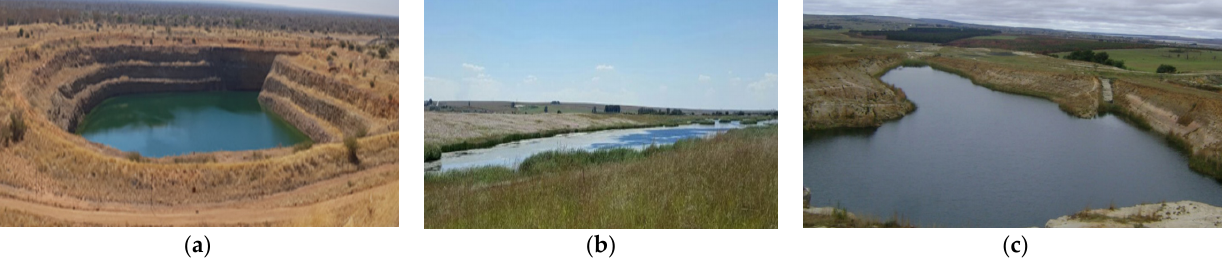
Figure 2. ( a ) Mafutha pit lake (September 2018); ( b ) Kriel pit lake 4: Ramp 44 North (March 2017); and ( c ) Rooikop pit lake (November 2017) [2]. Table 1. Pit lakes’ characteristics.